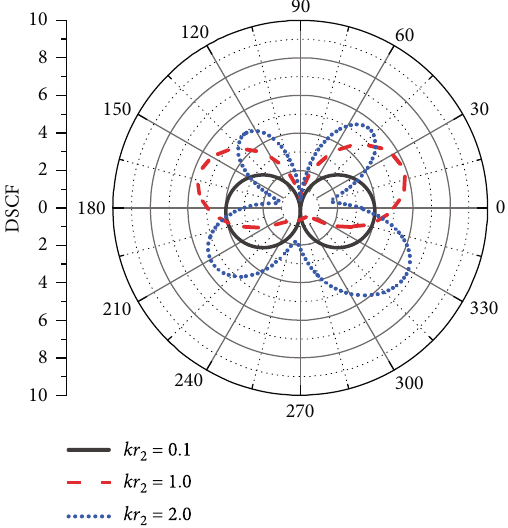
Figure 6: DSCF distribution of the circular hole at di ff erent frequencies ( d / r 2 = 3 : 0 and h / r 2 = 5 : 0 ).